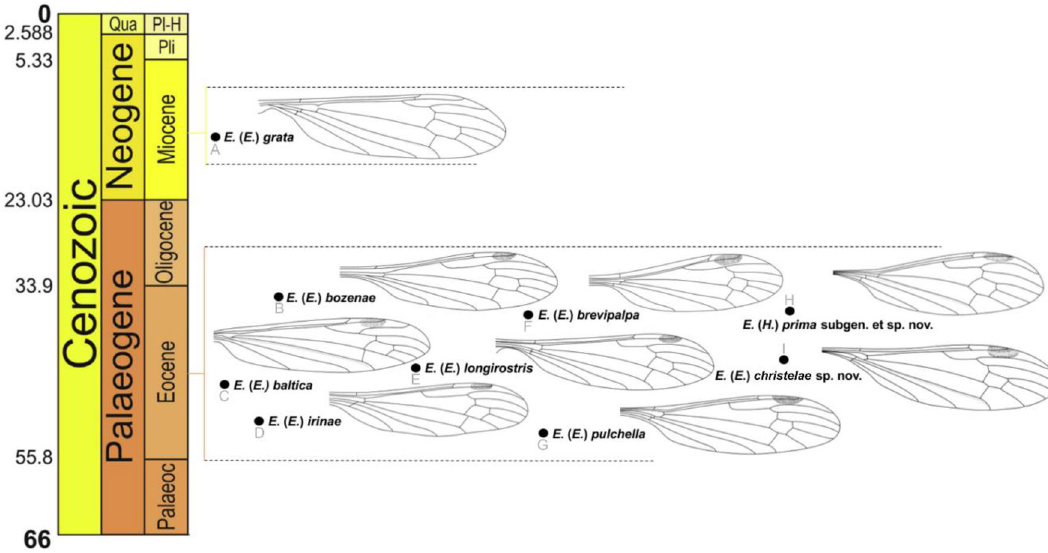
Figure 8. Chronostratigraphic distribution of Elephantomyia , fossil species, wings redrawn after Podenas and Poinar 9 ; Kania 8 . Stratigraphic chart according to International Stratigraphic Chart, International Commission of Stratigraphy (v. 2021/05) https:// strat igrap hy. org/ chart (accessed on 16 September 2021).